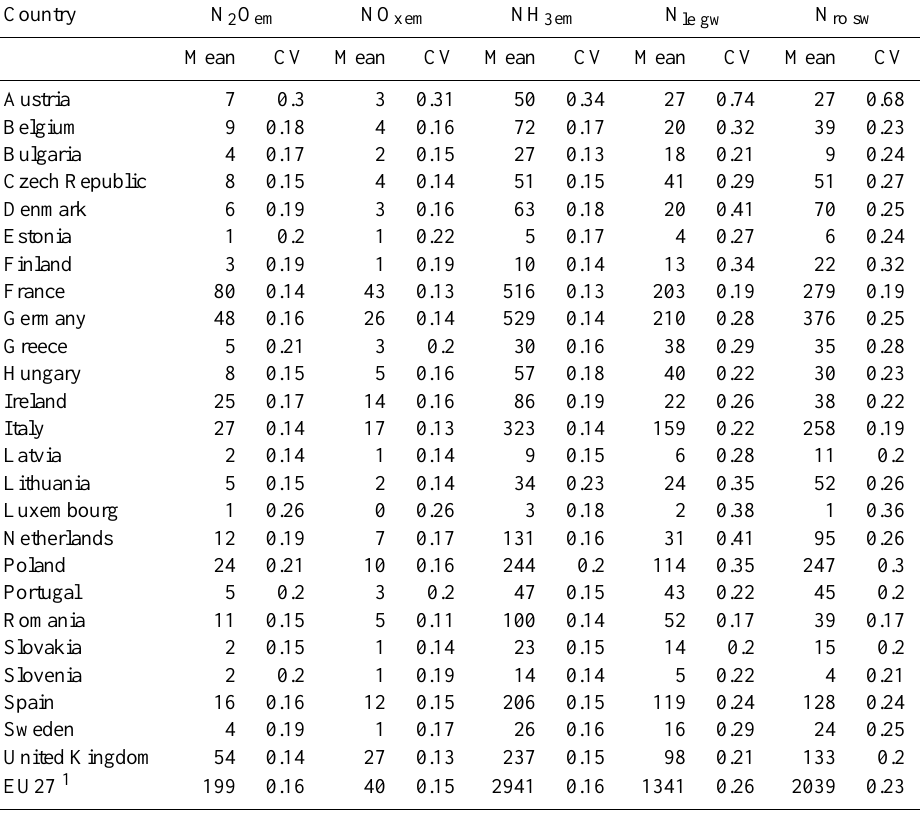
Table 6. Overall uncertainty expressed as CV (SD/Mean) and Mean (in kton N yr − 1 ) in the area-weighted average N 2 O emission (N 2 O em ) , NO x emission (NO x em ) , NH 3 emission (NH 3 em ) , N leaching to groundwater (N le gw ) and N runoff to surface water (N ro sw ) per country for the year 2000.